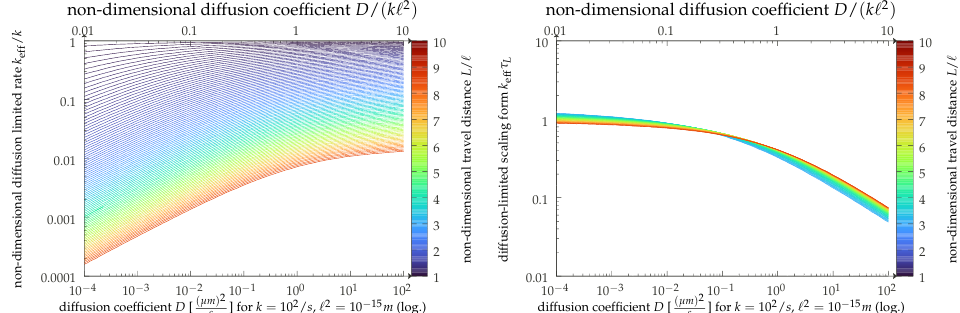
Figure 4. Effective production rate k eff given by the inverse of the mean first reaction time in the Doi model presented in the main text, with some additional details given in Appendix A. We present the results in dimensionless units (upper ordinate axis) and using exemplary physical values (lower axis). Left : Direct results for k eff as a function of the particle diffusion coefficient for varying ratios of domain size L and interaction range (cid:96) as coded by line color. Right : The same data, but directly τ − 1 employing the diffusion-limited scaling k eff . Here, we show only data for larger values of L ∼ L / (cid:96) > 3, where the scaling is expected to